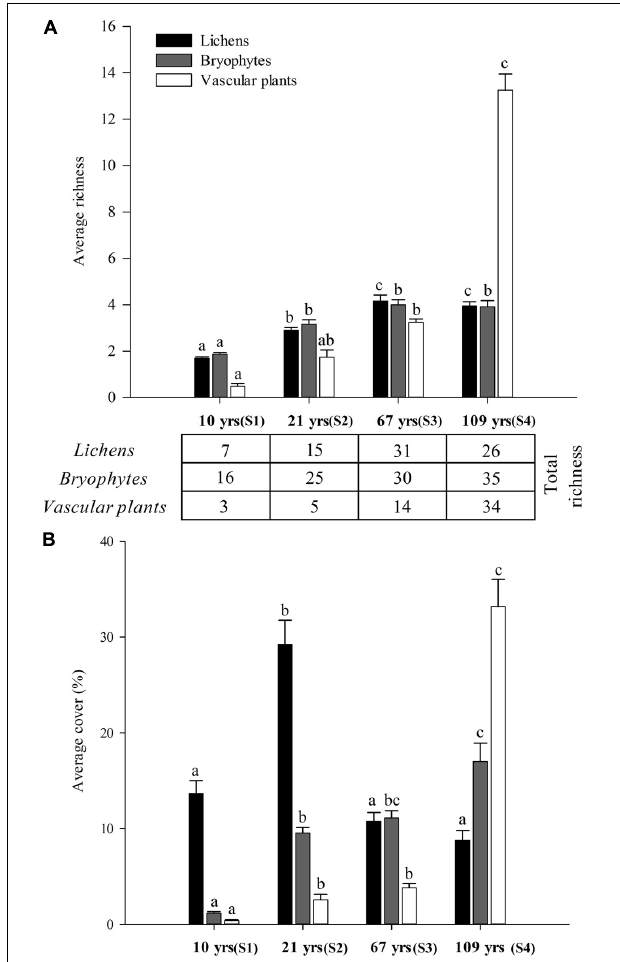
FIGURE 2 | Changes in total species richness and average richness (A) and cover (B) for lichens, bryophytes and vascular plants in four study sites (S1-S4) along a post-glacial chronosequence (10–109 years of succession) at Humboldt Peak, Venezuela. Different letters indicate significant differences across successional stages for each group of organism analyzed separately (i.e., differences between seral stages, permutational t -test, α =